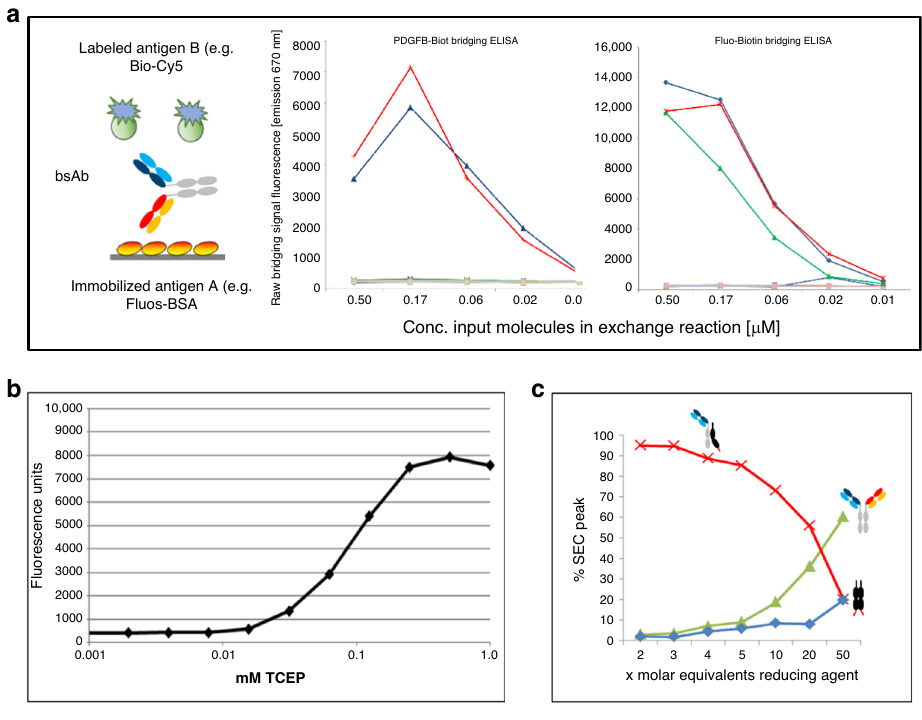
Fig. 4 BsAb formation can be detected in raw reaction samples via bridging-ELISA and be quanti fi ed by SEC. a Bridging-ELISA and detection of functional bsAbs in raw reaction mixtures without prior puri fi cation. Red lines represent hole – knob combinations, blue lines the knob – hole combinations of the respective target antibodies.The green line in the upper right panel is a conventionally produced bsAb control. Additional traces are negative controls (raw reaction mixtures of control antibodies that do not match the antigens used in the respective bridging ELISA). b Bridging ELISA indicates that productive exchange requires reduction for initiation. SEC (see also left panel of Fig. 3b) quanti fi cation determines TCEP concentrations that enable effective initiation of exchange (TCEP dependent formation of exchange products after 1 h 37 °C monitored by analytical